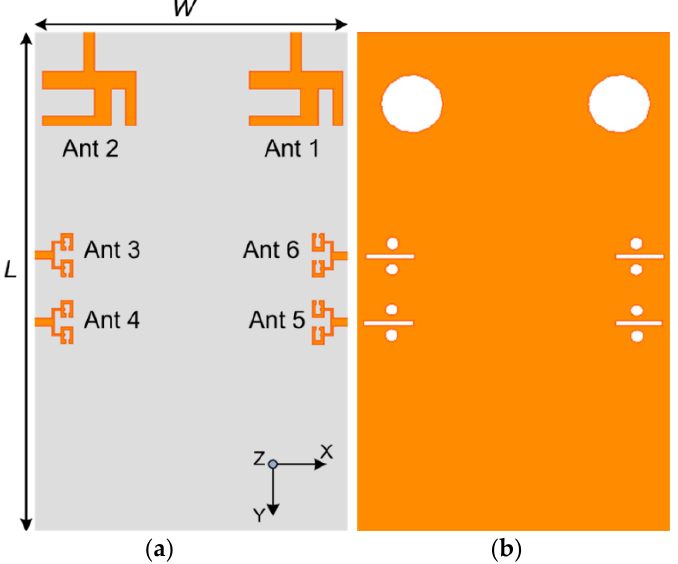
Figure 1. Geometry of the Integrated LTE (Long Term Evolution) and 5G MIMO (multiple-input multiple-output) Antenna System: ( a ) Top View; ( b ) Back View (Dimensions are in millimeter).